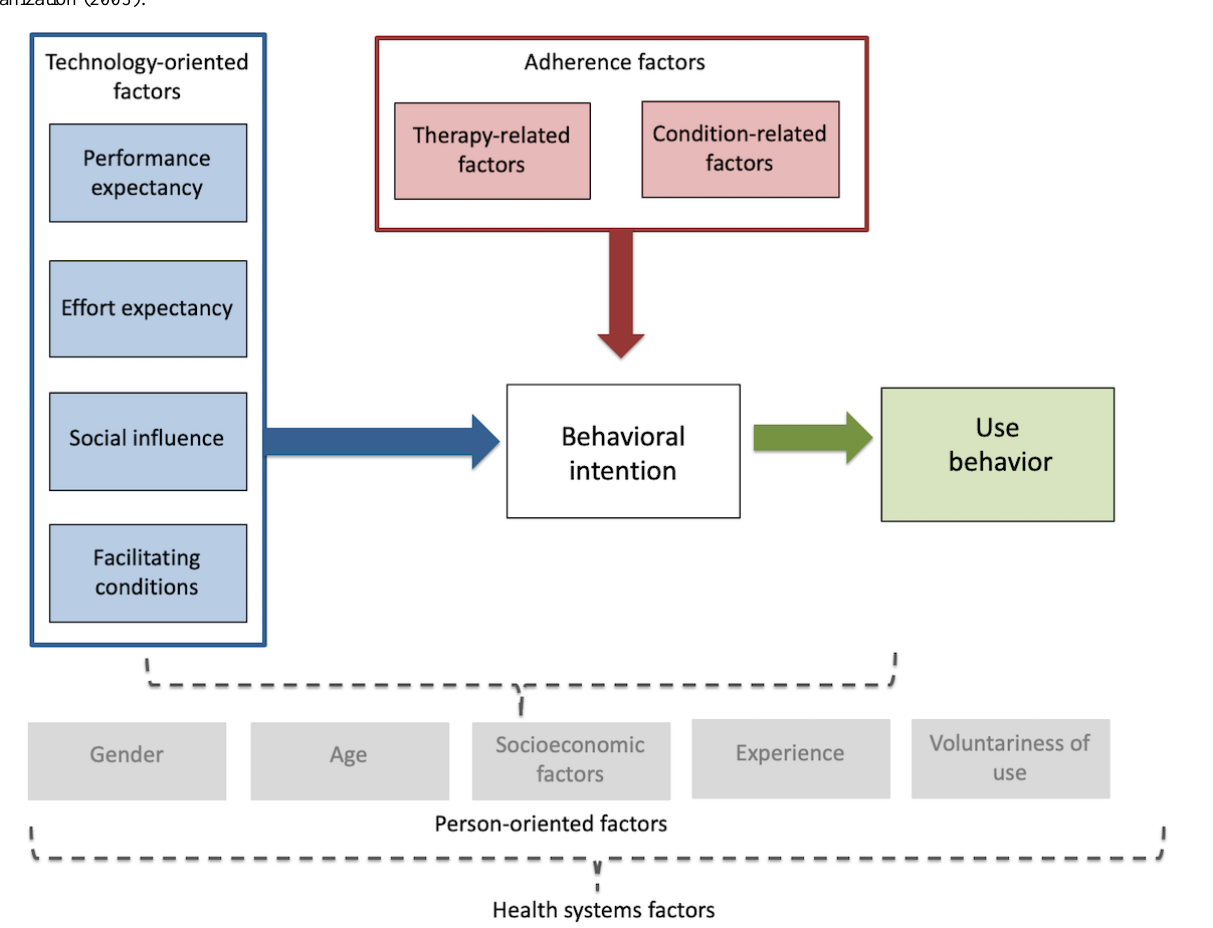
Figure 1. Modified unified theory of acceptance and use of technology model for adherence factors adapted from Venkatesh (2003) and World Health Organization